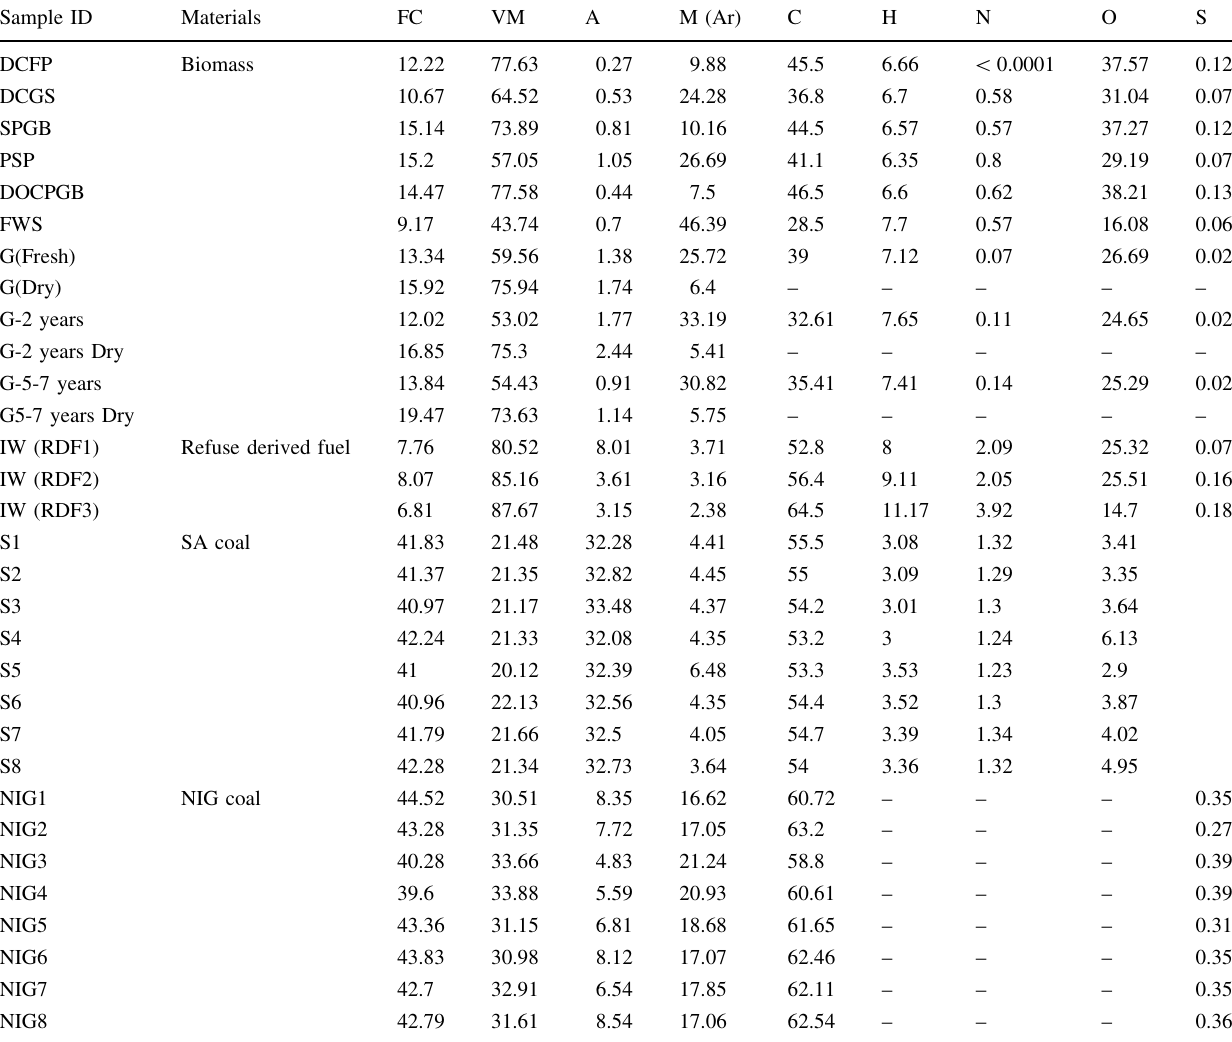
Table 1 Proximate and elemental analysis (wt%) data obtained from the experimental tests Sample